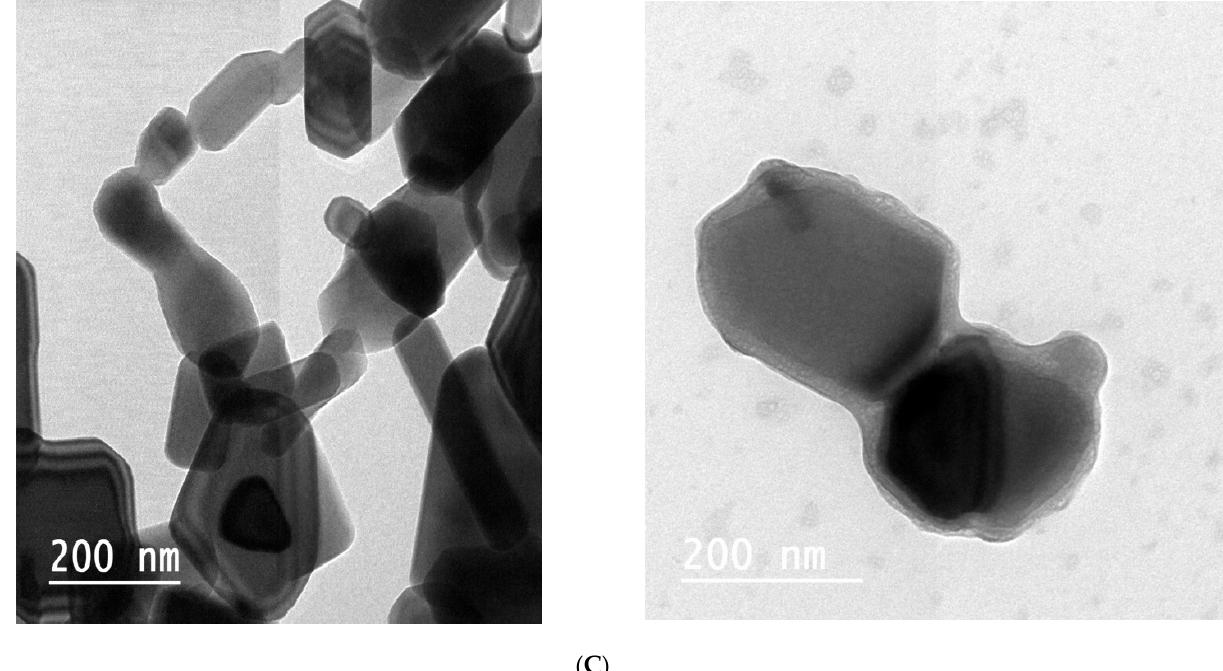
Figure 4. TEM micrograph ( A ) AgNPs , ( B ) ZnONPs, ( C ) TiO 2 NPs.